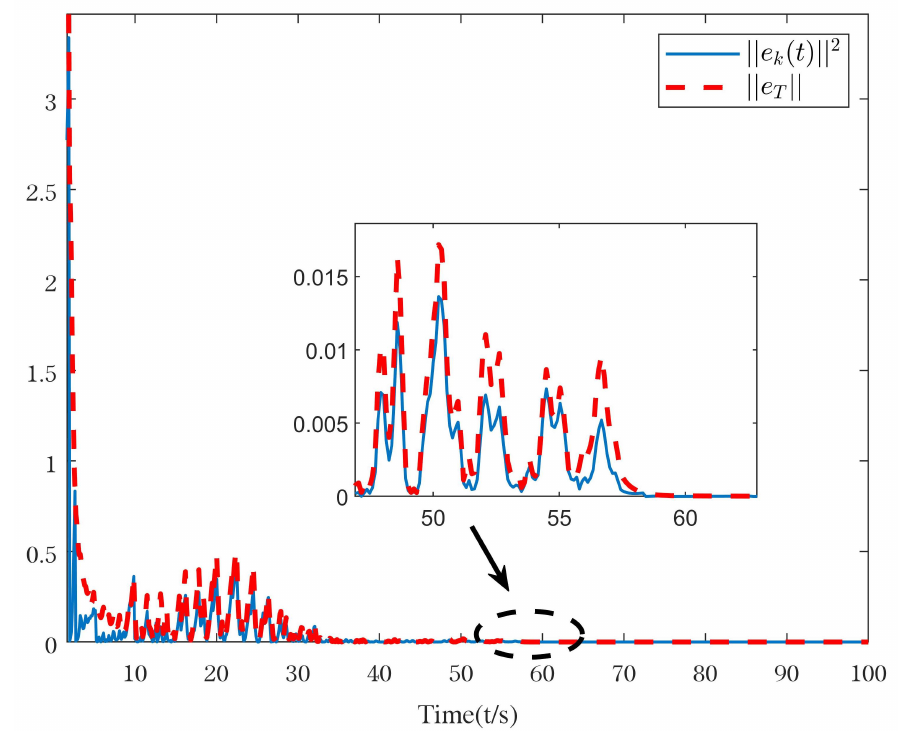
Figure 5. The event error (cid:107) e k (cid:107) 2 and the triggering threshold e T .